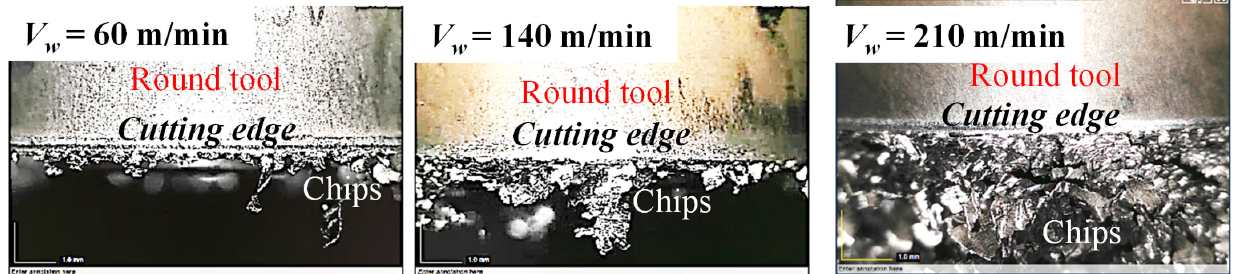
Figure 7. The chips adhered on the cutting edge of a round tool.